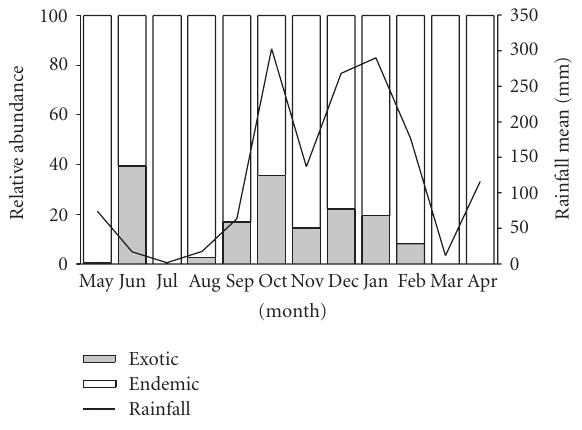
Figure 2: Temporal variation in rainfall and in the proportion (%) of neotropical and exotic drosophilids in fruits of Mauritia flexuosa collected in a gallery forest of the Ecological Reserve of IBGE, Bras´ılia, DF.